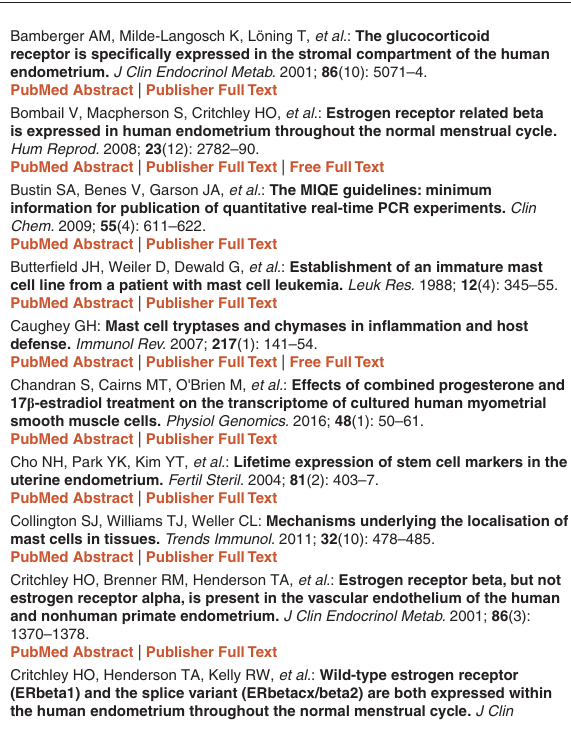
Supplementary Figure 5. Mast cells and progesterone receptor (PR) immunoexpression in the human uterus. Mast cells were dem- onstrated to be immunonegative for PR expression (red staining), across “full thickness” uterine sections and during both the proliferative and secretory phase. (Proliferative n=5, Secretory